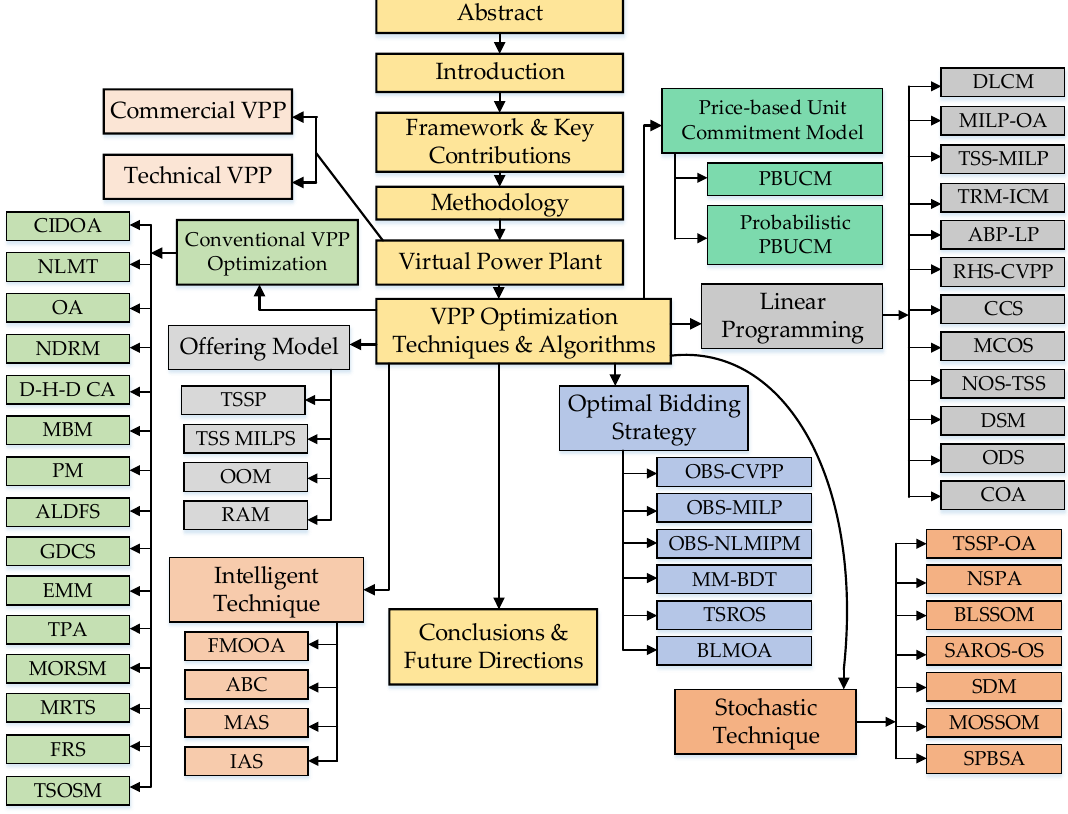
Figure 1. A representation of the information flow of this paper for a comprehensive analysis of virtual power plant optimizations.